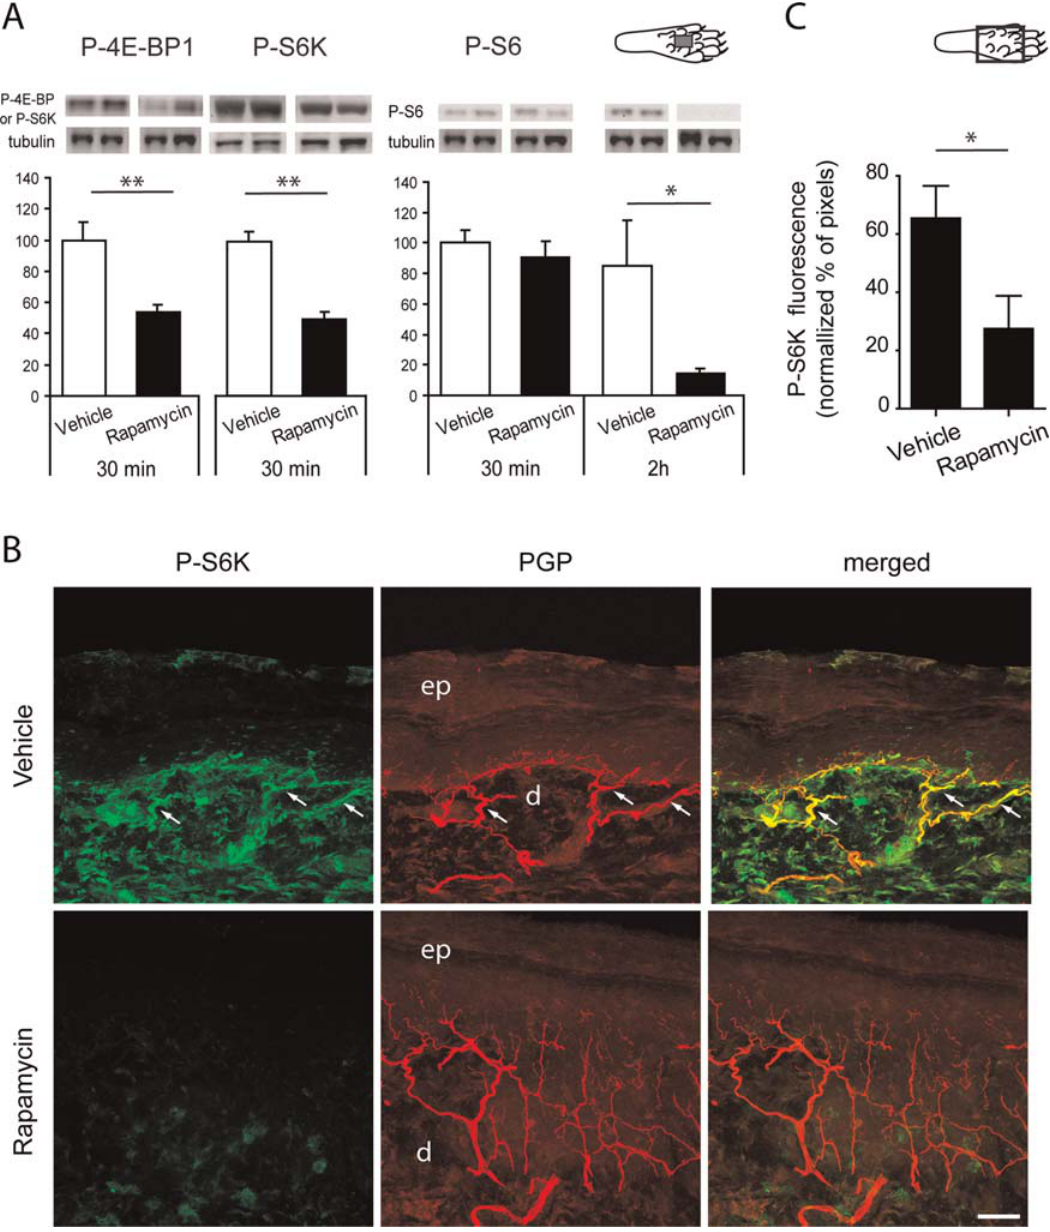
Figure 3. Rapamycin decreases phosphorylation of downstream targets of mTOR in the skin. A , Immunoblots probed with anti-phospho- 4E-BP1/2, anti-phospho-S6K and anti-phospho-S6 antibodies after gel electrophoresis of lysates from skin tissue of the plantar surface of the hindpaw. Animals received an injection of rapamycin or vehicle in the center of the plantar surface 30 min or 2 h before sacrifice. The intensity of the bands for each antibody was normalized with the intensity of the b 3-tubulin signal. There was a significant reduction in 4E-BP1/2 and S6K phosphorylation 30 min after rapamycin injection. The reduction in S6 phosphorylation was seen 2 h after rapamycin injection. n=3–4 in each condition. B , Confocal images of phospho-S6K immunostaining ( green ) in the glabrous skin 30 min after intraplantar injection of rapamycin or vehicle in the center of the plantar surface of the hindpaw. PGP staining is shown in red and double staining appears in yellow. White arrows indicate double- labelled fibers. Note the overall decrease of phospho-S6K labelling after rapamycin injection. ep, epidermis; d, dermis. Merge of 24 z-focal planes (22 m m depth). Scale bar, 50 m m. C , Semi-quantification of phospho-S6K immunofluorescence in the plantar skin nerve fibers. The y axis represents the percentage of normalised phospho-S6K pixels above a threshold of 50. Measurements were made from confocal images as in B . Diagrams of the plantar surface of the rat paw indicating the area sampled (rectangle) are also included. * P , 0.05; ** P , 0.01.